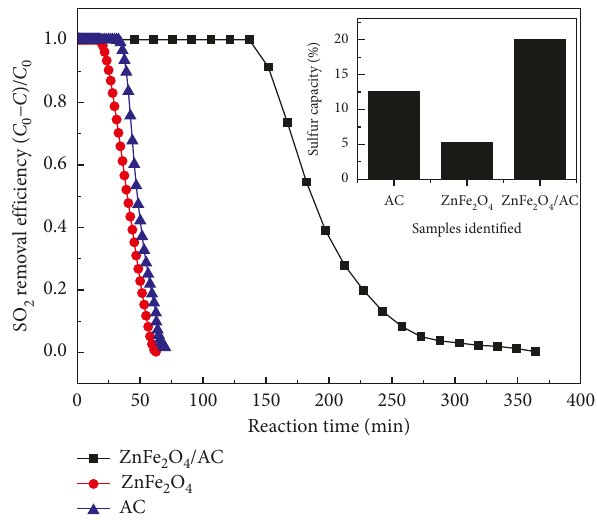
Figure 12: Comparison of the sulfur capacity of AC, ZnFe ZnFe 2 O 4 /AC